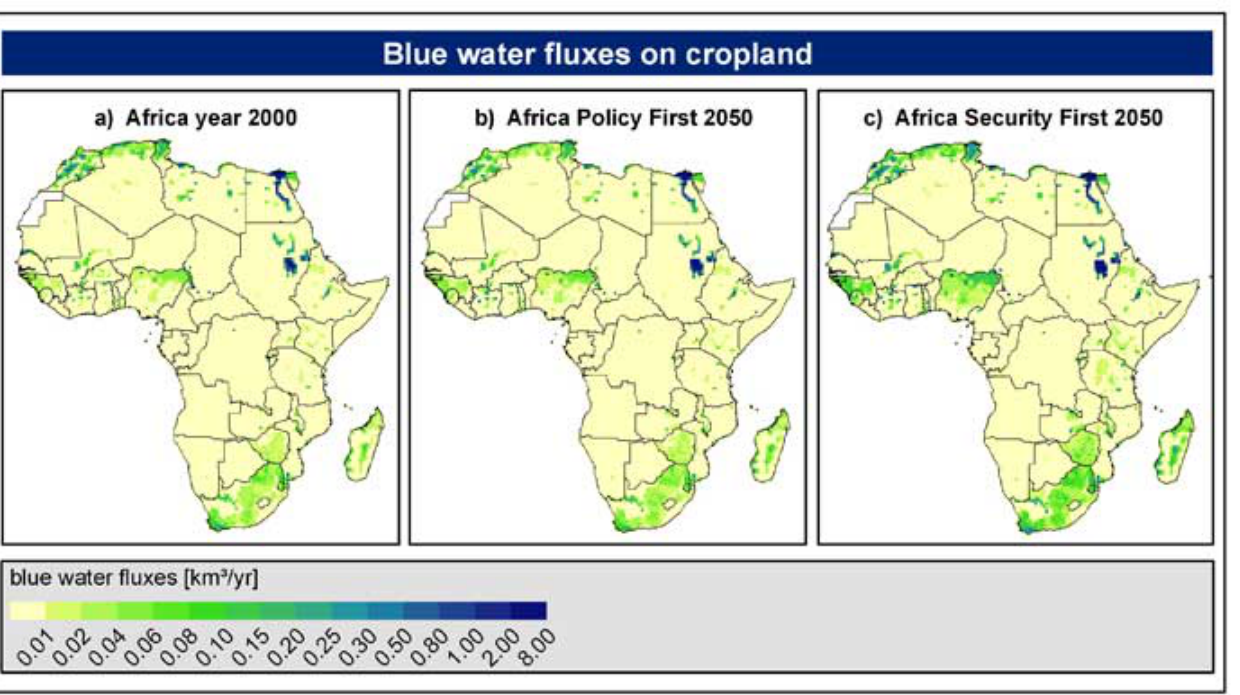
Figure 3. Blue water fluxes from cropland in Africa for (a) the year 2000, (b) the GEO-4 “Policy First” scenario in 2050, and (c) the “Security First” scenario in